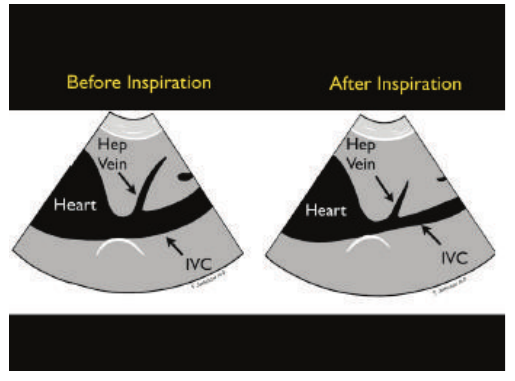
Figure 13: Collapsible inferior vena cava, long axis